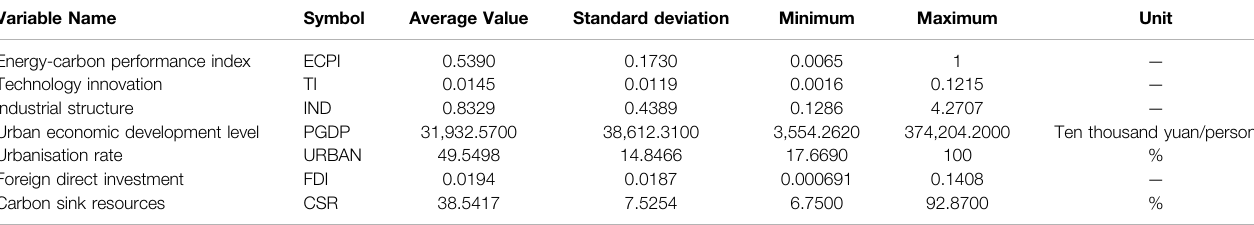
TABLE 1 | Descriptive statistics of raw data.